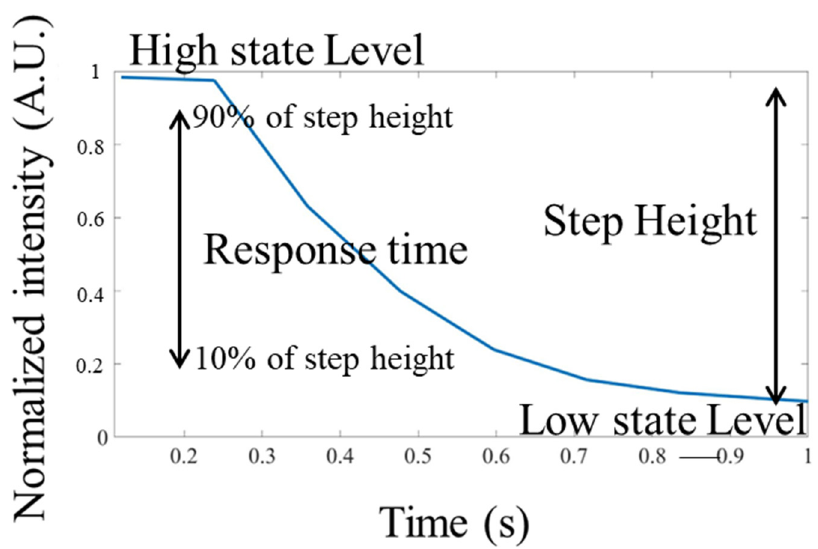
Figure 3. Schematic diagram for calculation of response time.